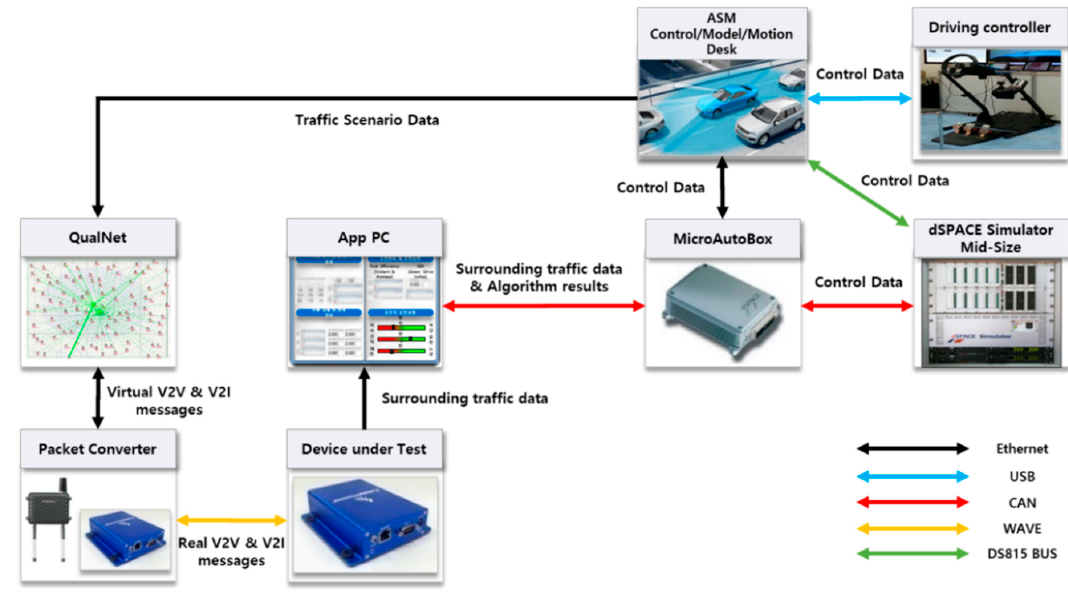
Figure 4. Data flow of IDHIL simulator.